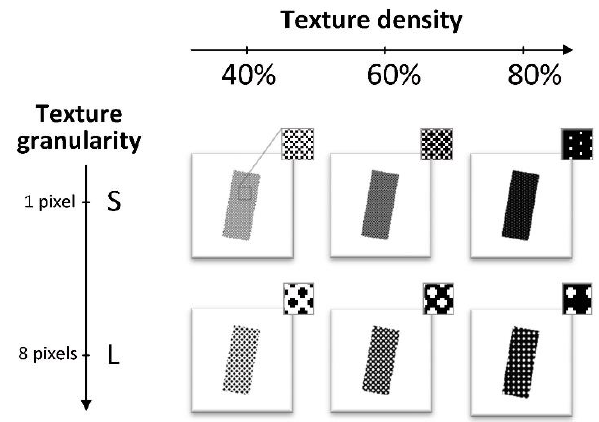
Figure 6. Textures. Six different Textures are tested in the second group of tests, resulting from the combination of three possible densities (40%, 60% and 80%) and two possible granularities (1 or 8 pixels in diameter, respectively Small “S” and Large “L”). Each texture was tested in four different Luminance values: 001, 064, 128 and 192 #Lum.